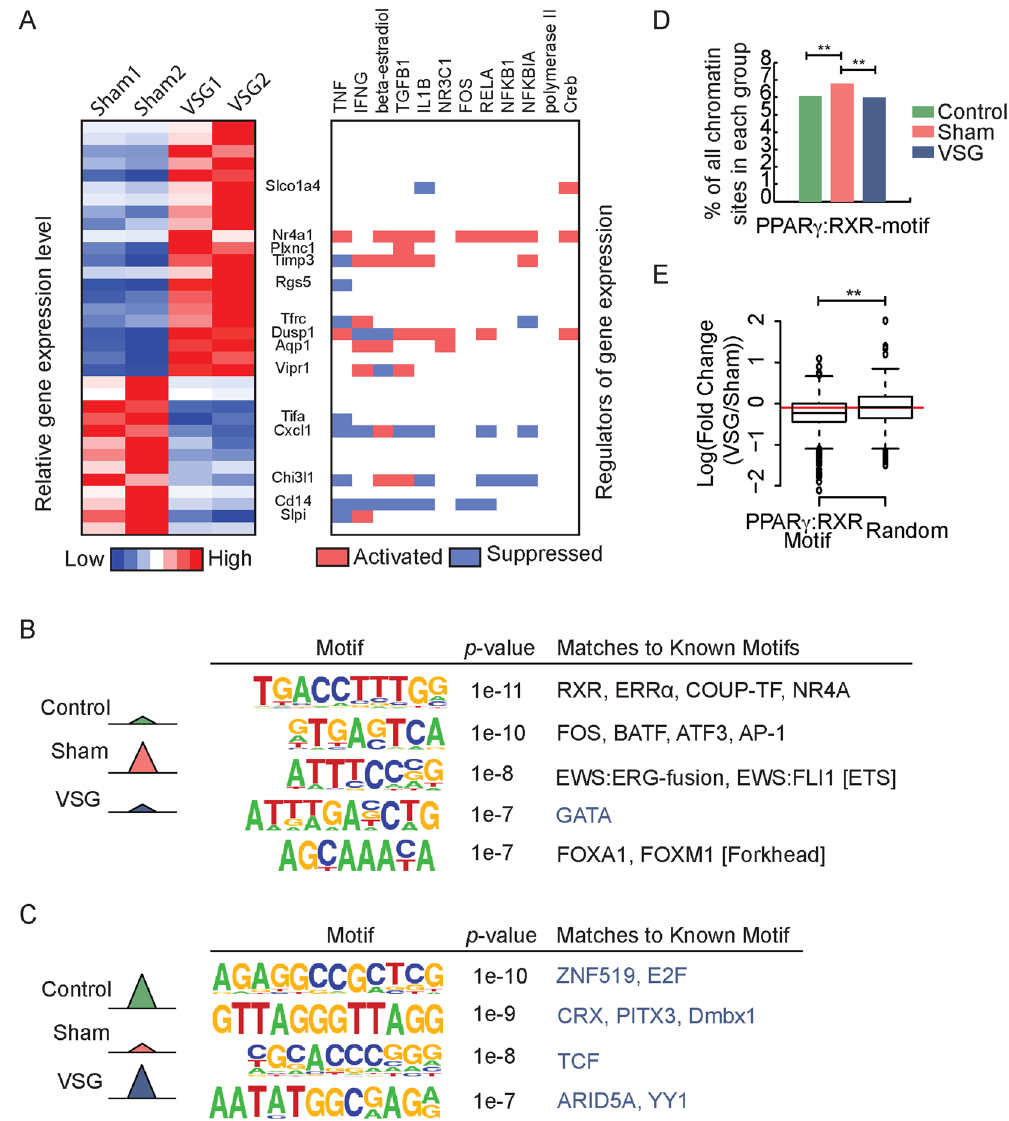
Figure 5. Upstream regulators altered by VSG. ( A ) Heatmap of differentially express genes between Sham and VSG (left), and upstream regulators from Ingenuity Pathways Analysis (right). ( B and C ) Identified motifs from reversible chromatin sites that are more ( B ) or less ( C ) accessible in Sham compared to Control and VSG. Numbers in parentheses represent p -values of enrichment of motif occurrence in the given set of sequences compared to background, and the percentage of sequences with the motif. ( D ) Percentage of accessible chromatin site in each group that contained PPAR γ :RXR motif ( ** Indicates p < 0.01, Fisher’s exact test). ( E ) Fold change (VSG vs Sham) of FAIRE read counts within chromatin sites contain PPAR γ :RXR motifs or random chromatin sites ( ** Indicates p < 0.01, Wilcoxon’s rank-sum